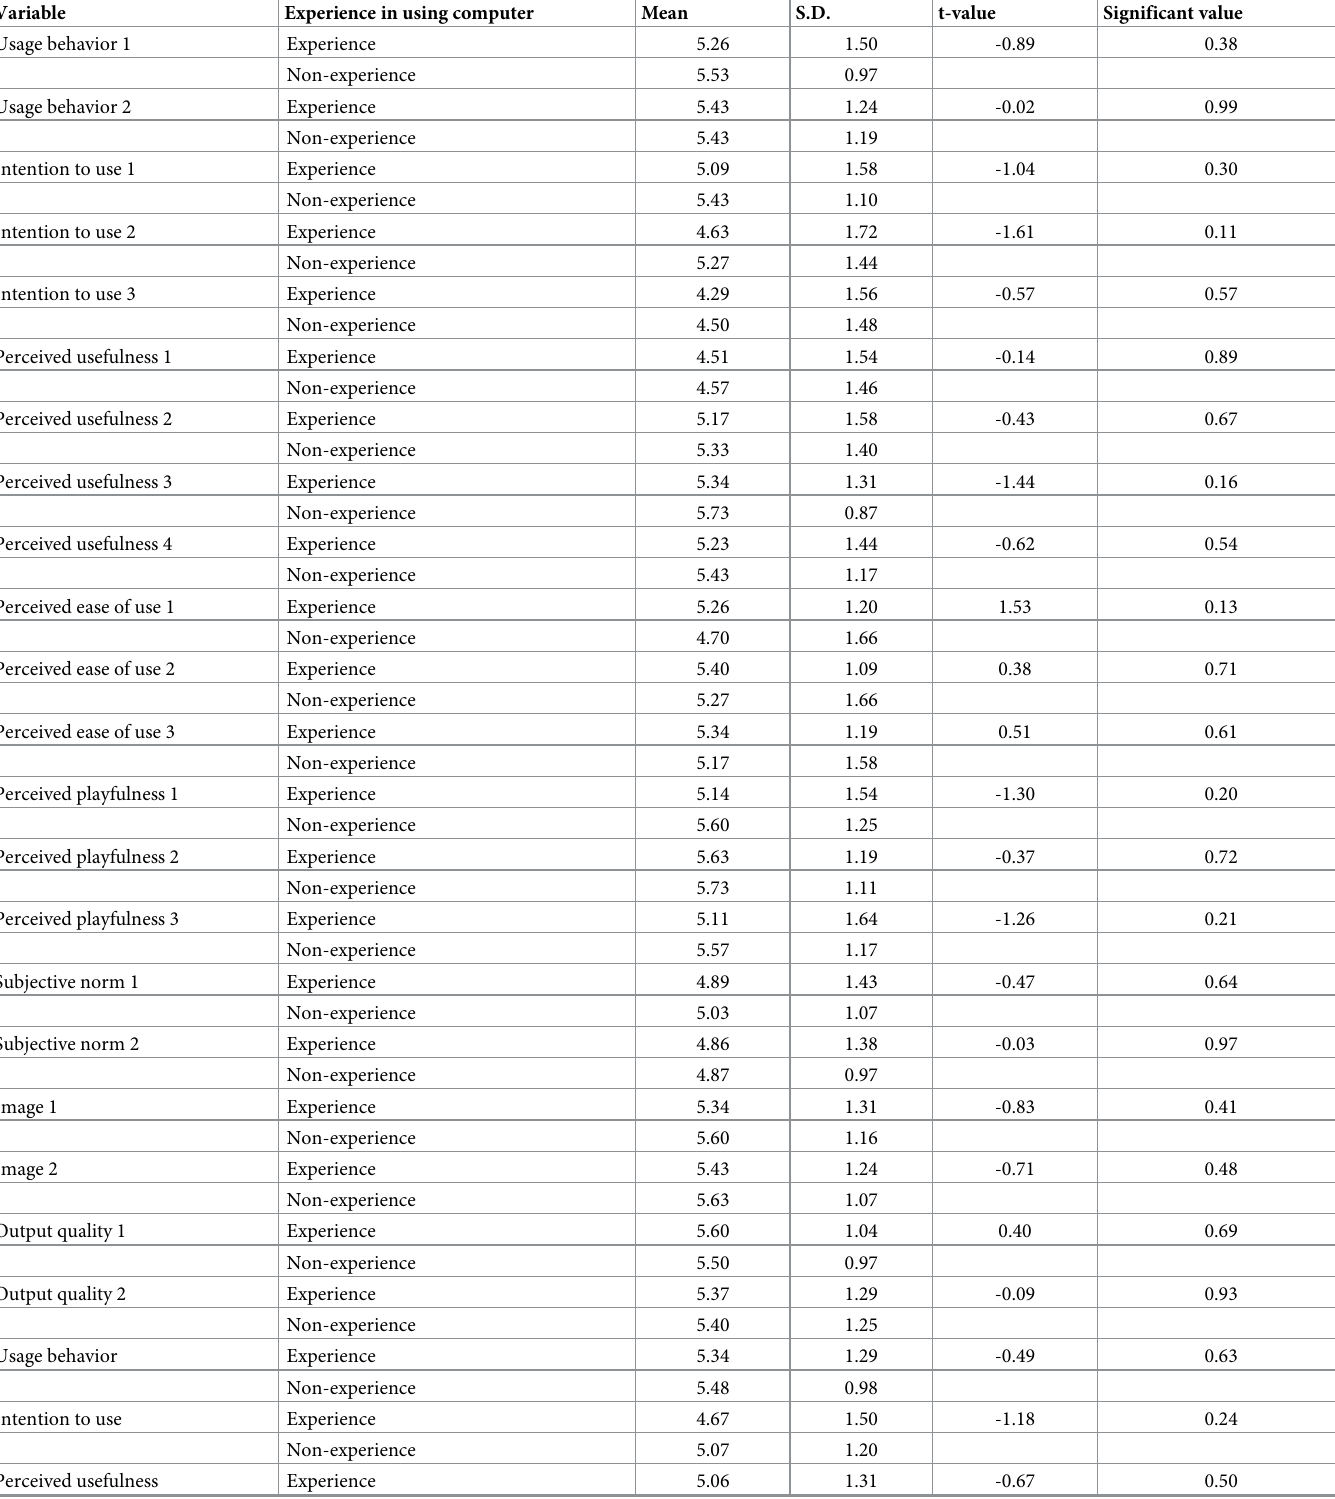
Table 2. t-test on cognitive exergames between experienced and non-experienced computer users on the questionnaire items and variables.